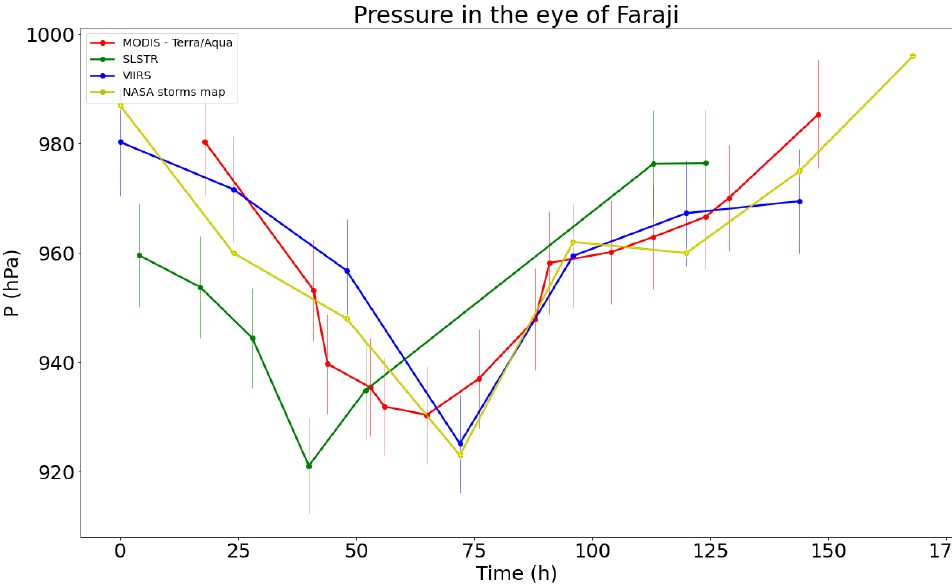
Figure 15. Temporal comparison between the pressure in the eye of the Faraji cyclone derived from the polar-satellite remote sensing techniques and the same values obtained from NASA storms map of Zoom Earth database. Vertical thin lines in each point value represents the uncertainty ranges of the